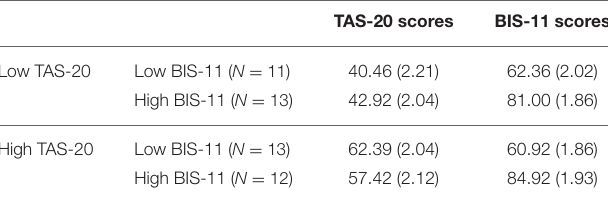
TABLE 4 | Means (and standard errors) of the TAS-20 and BIS-11 scores for the alexithymia by impulsivity